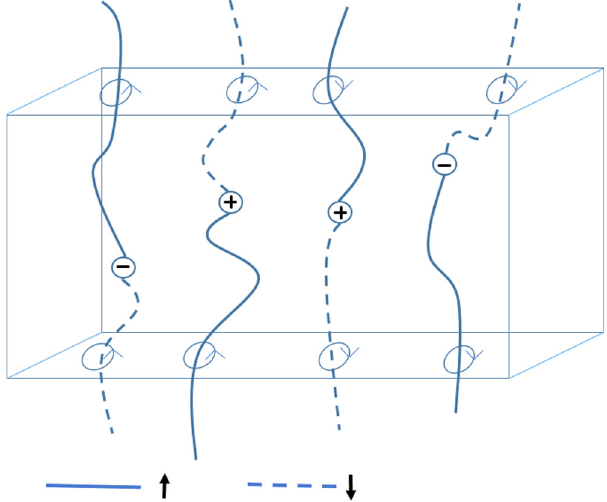
FIG. 2. As discussed in the text, the easy-plane spin system has two species of vortex lines, ↑ and ↓ , depending on n c at the core. A hedgehog is a transition point between the two types of lines, with the sign of the hedgehog determined by the orientation of the type and vorticity of the vortex lines, as shown with examples. This figure shows only the spatial dimensions of the system; therefore, the hedgehogs are point particles and the vortices are lines. Applying a Zeeman field to the surface means allowing only one type of vortex line through the surface. This leads to a correlation between the hedgehog number (and therefore the boson charge) and the vorticity at the surface, which is the origin of the Hall